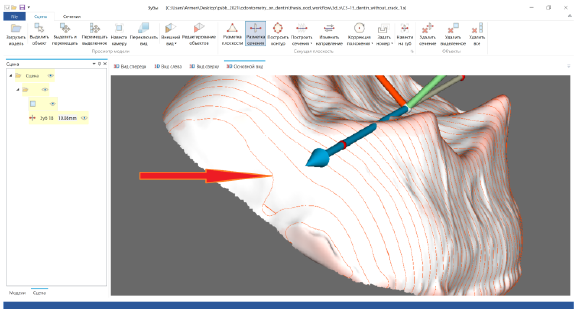
Figure 5. The red arrow points at the excluded contour.